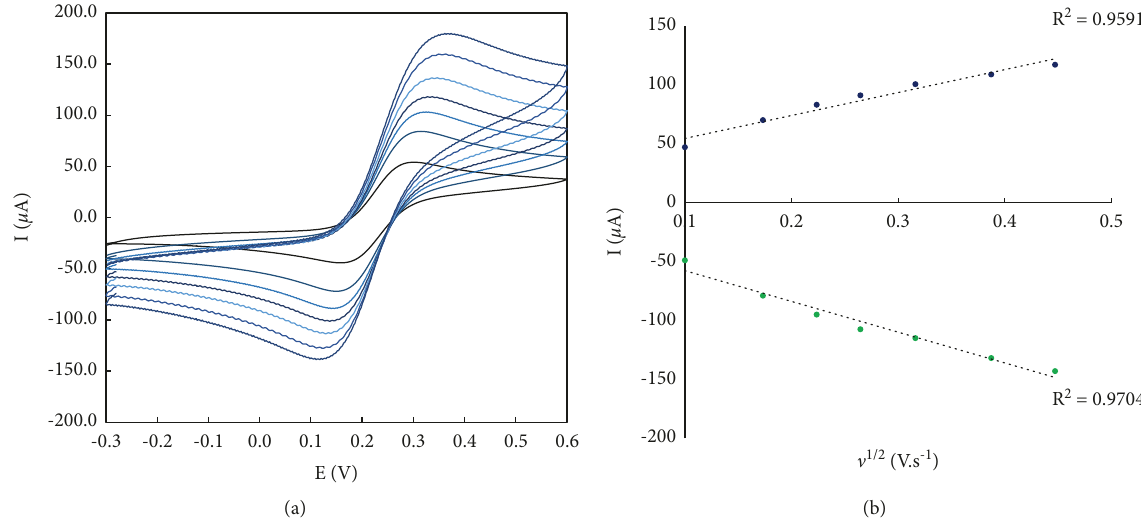
Figure 7: (a) Evaluation of the electrokinetic behavior of the developed sensor via CV method under variable scan rates for anodic and cathodic peak currents; (b) calibration curve of anodic and cathodic peak currents at diverse scan rates.